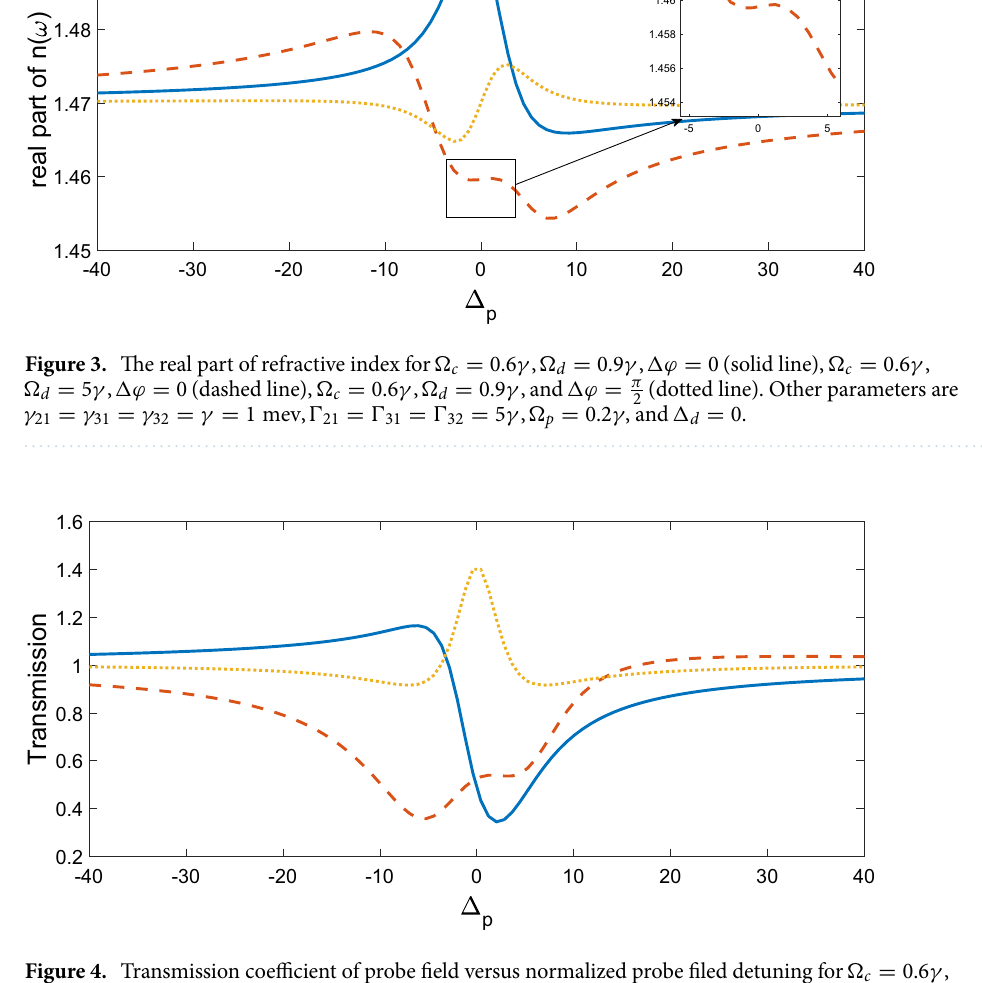
Figure 4. Transmission coefficient of probe field versus normalized probe filed detuning for � c = 0.6 γ , � d = 0.9 γ , �ϕ = 0 (solid line), � c = 0.6 γ , � d = 5 γ , �ϕ = 0 (dashed line), � c = 0.6 γ , � d = 0.9 γ , and �ϕ = π 2 (dotted